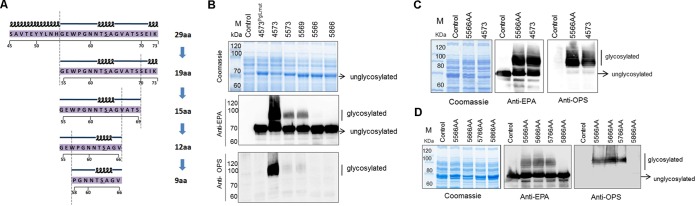
Determination of the minimum recognition motif for the O-linked glycosylation system. (A) A schematic of how the sequence of PilE 45S-73K was shortened step by step from 29 amino acids (aa) down to 9 amino acids, according to its secondary structure. (B) Coomassie blue staining and Western blotting assays were used to analyze the glycosylation of the sequences depicted in panel A. 4573 indicates a fusion of the S45-K73 fragment at the N terminus of rEPA (pET-pglL-rEPA4573N), and other fusion patterns are indicated similarly. The control was strain 301DWP lacking plasmid, and 4573PglLmut indicates the expression of PglLmut (pET-pglLmut-rEPA4573N). (C) Two hydrophilic fragments were added before and after the 12-amino-acid sequence (pET-pglL-rEPA5566AA), and glycosylation was assessed as in panel B. (D) The recognition motif was shortened to 10 amino acids (57WPGNNTSAGV66), based on 5566AA, and glycosylation was assessed as in panel B.